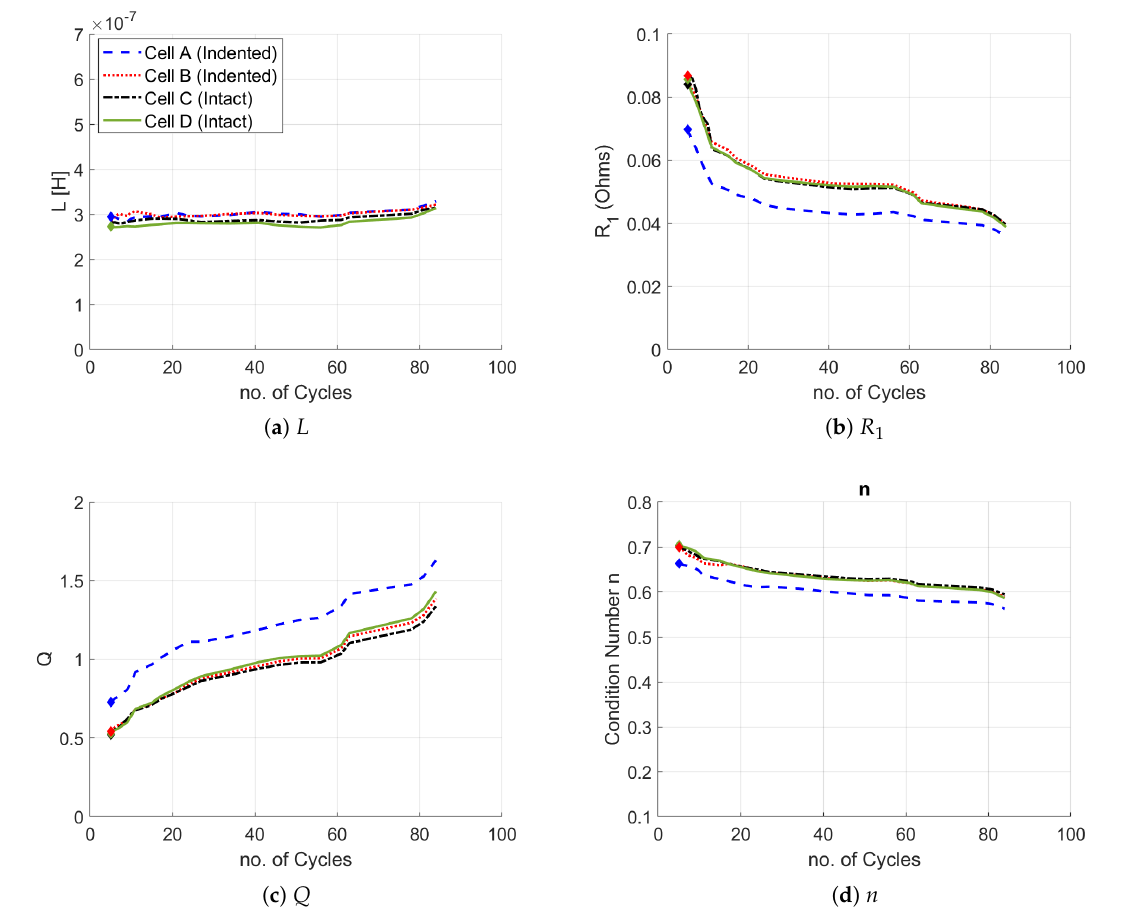
Figure 6. Trend of changes in parameters for all cells with cycling, ( a ) L , ( b ) R 1 , ( c ) Q , ( d ) n ,